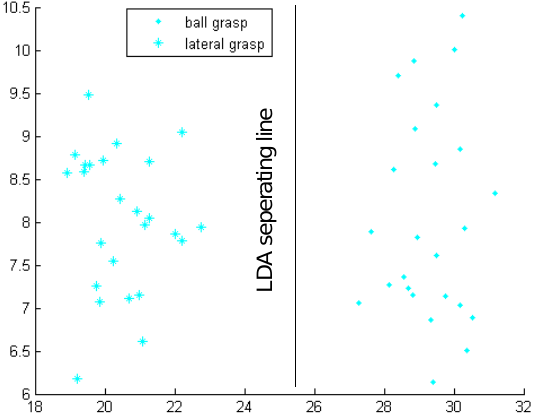
Figure 12. Classifier 2 in the second-level of the first subject.